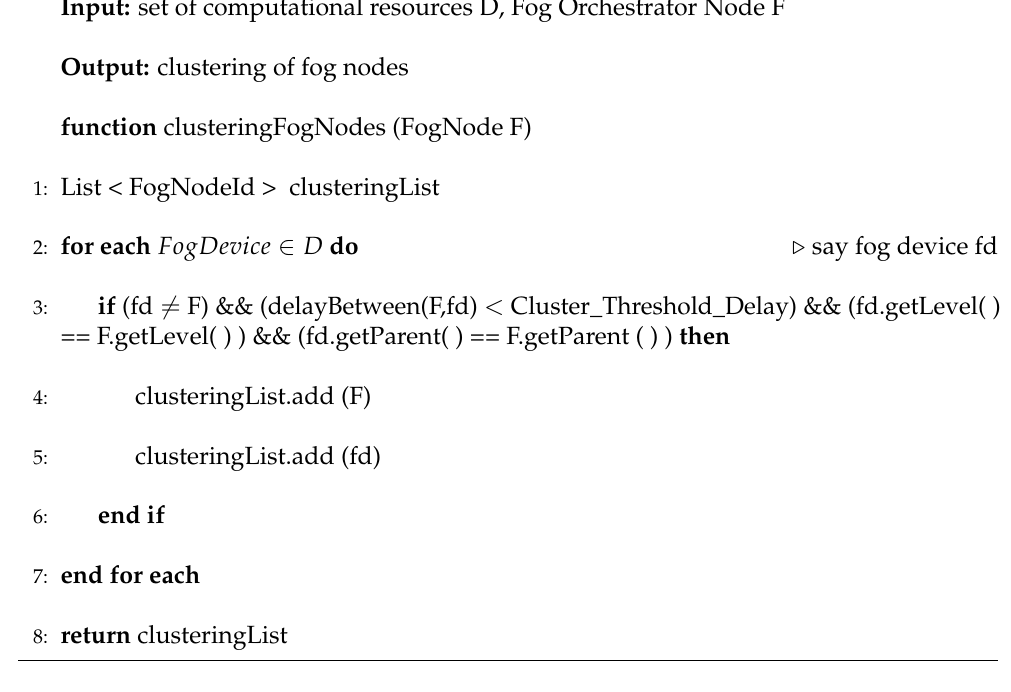
Algorithm 3 Clustering of